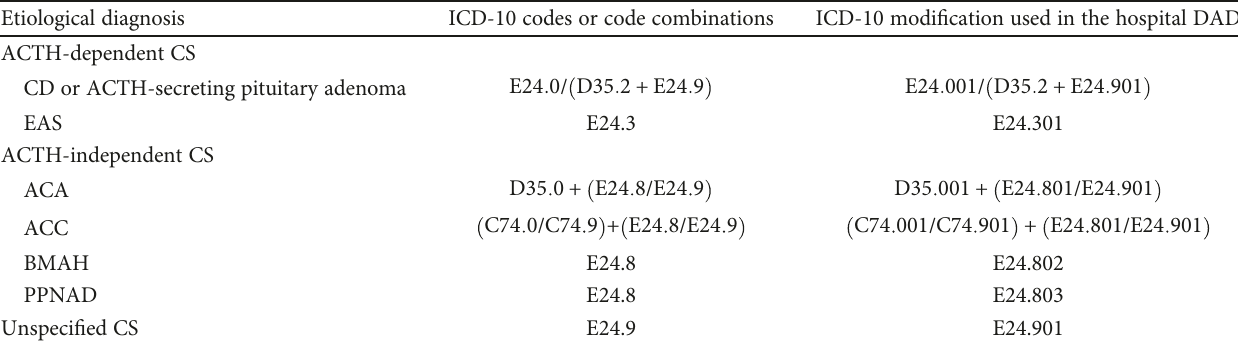
Table 1: Etiological diagnoses and ICD-10 codes of endogenous